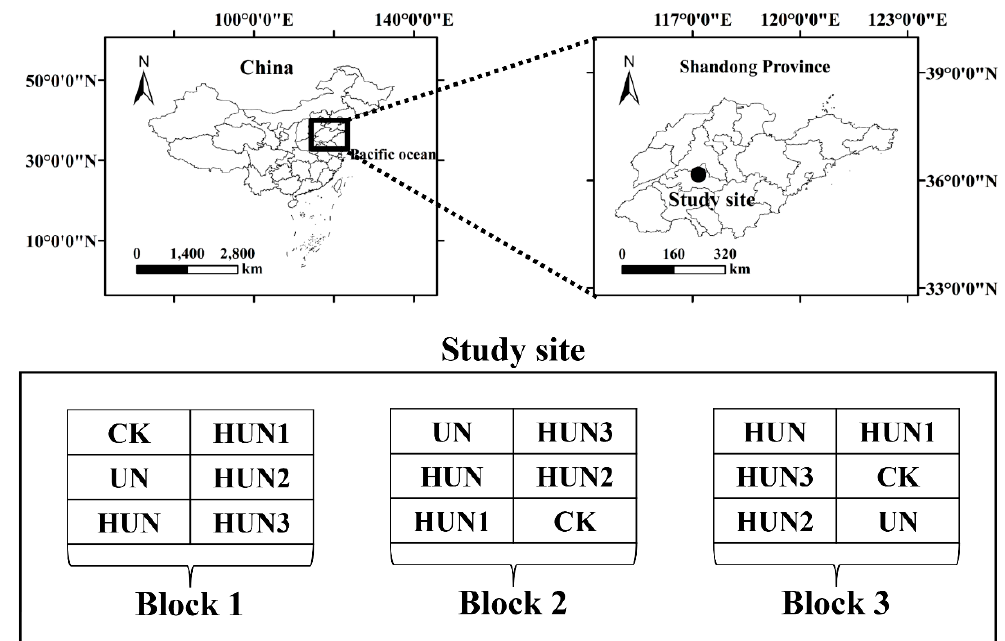
Figure 1. Location diagram of the study site. This map was created using Arcmap 10.8 software (https://developers.arcgis.com/, accessed on 2 November 2022).